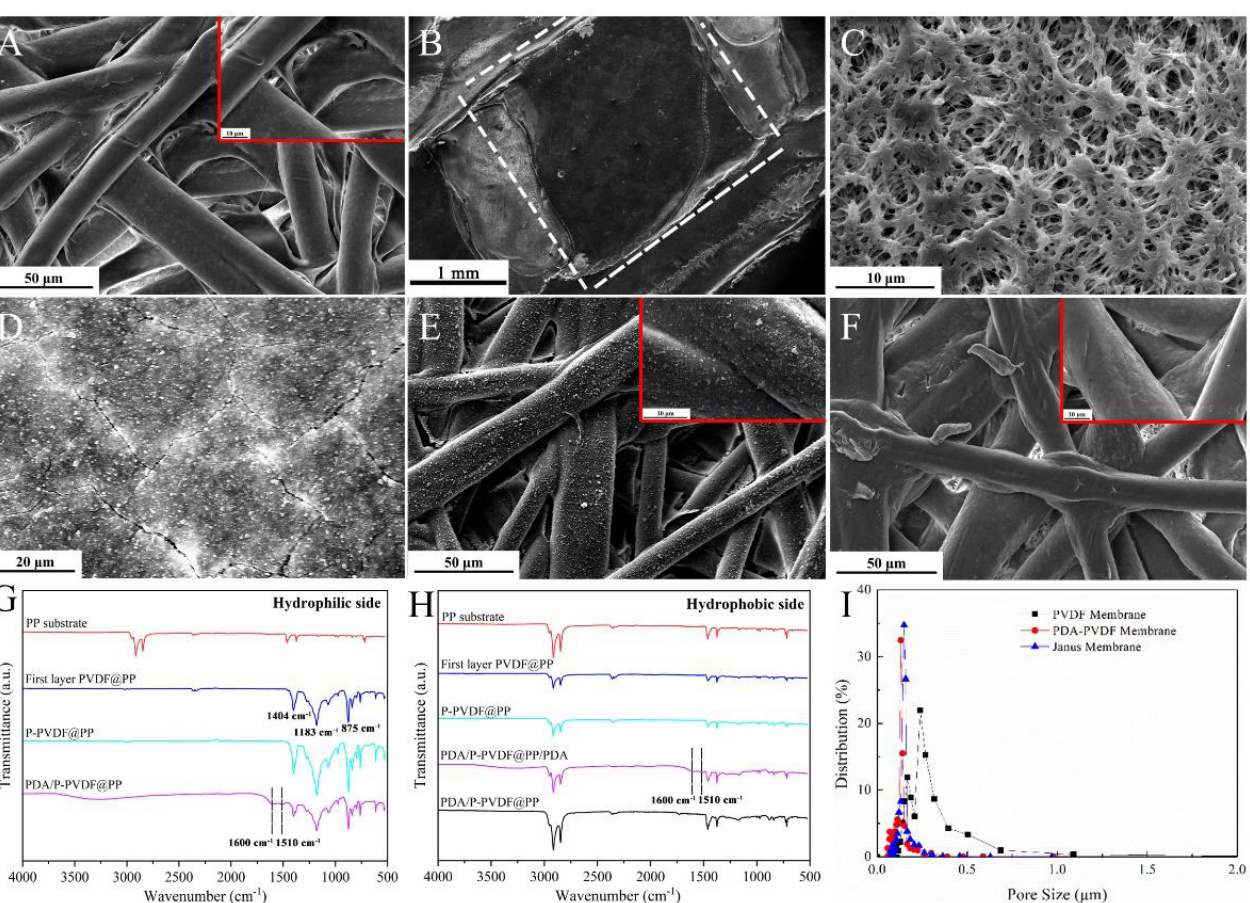
Figure 2. The SEM images (inserted are enlarged images) of ( A ) the PP membrane, ( B , C ) the P − PVDF@PP patterned surface, ( D ) the PDA/P − PVDF@PP Janus membrane surface, ( E ) the PDA/PP PVDF@PP patterned surface, ( D ) the PDA/P-PVDF@PP Janus membrane surface, ( E ) the PDA/PP surface, ( F ) the PDA/PP surface after peeling − off; the ATR − FTIR spectra of ( G ) the hydrophilic side surface, ( F ) the PDA/PP surface after peeling-off; the ATR-FTIR spectra of ( G ) the hydrophilic of the PDA/P − PVDF@PP, ( H ) the hydrophobic side of the PDA/P − PVDF@PP, ( I ) the pore size dis- side of the PDA/P-PVDF@PP, ( H ) the hydrophobic side of the PDA/P-PVDF@PP, ( I ) the pore size tribution of as − prepared membrane. distribution of as-prepared